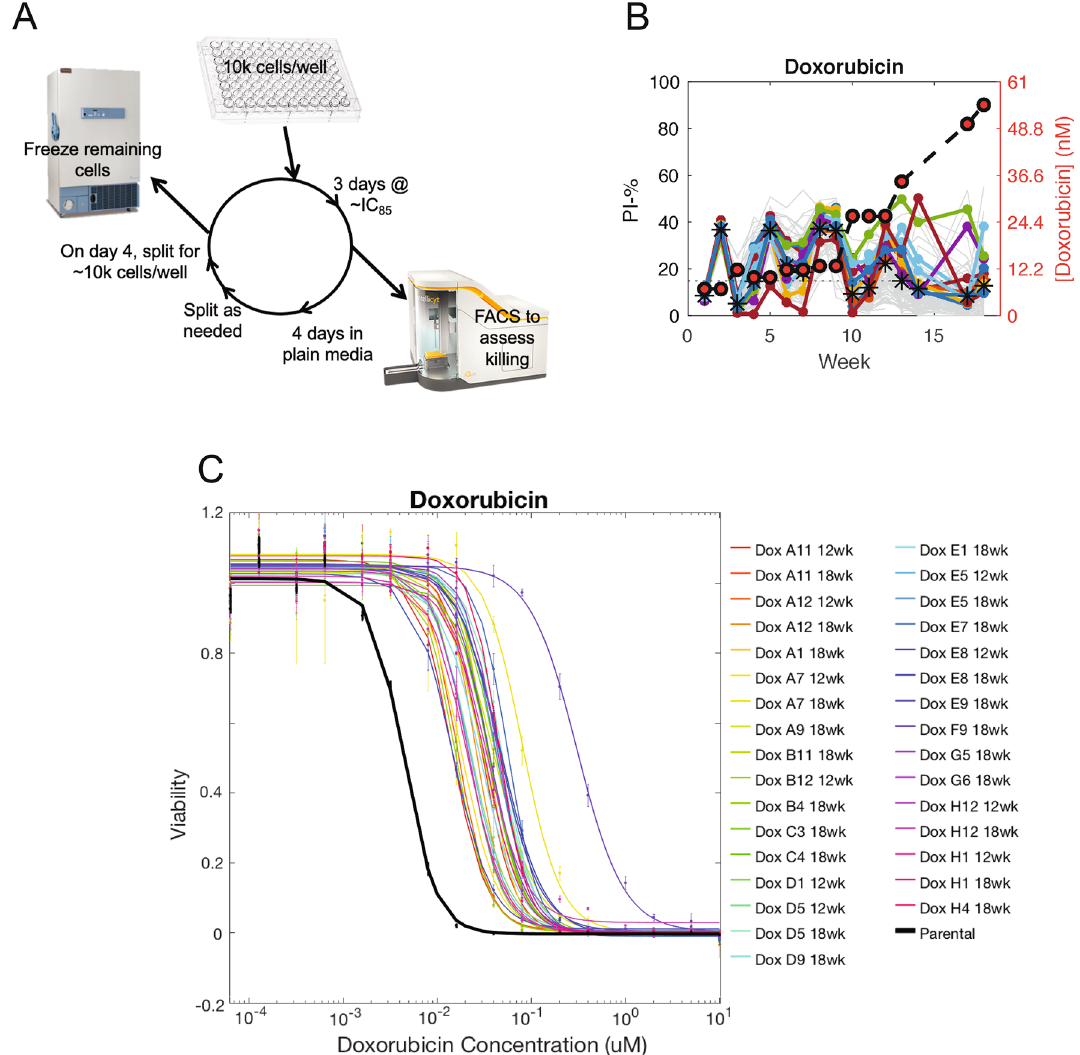
Figure 1. Protocol to create multiple evolutionary replicates of classical chemotherapy-resistant cell lines in parallel. (A) Schematic of protocol. In each cycle, 10,000 cells were seeded in each well of a 96-well plate and treated at a dose to kill 85% of cells after three days. Killing was assessed via FACS and cells were allowed to recover for four days. Cells were split, frozen, and the cycle re-started. (B) The fraction of live cells present in each well over each cycle of the resistance evolution experiment as assessed by PI staining (left y-axis). The dose of doxorubicin used each week is plotted with red circles on the right y-axis. Colored lines represent the most viable cell lines over the last five cycles of the experiment of the experiment. (C) Quantification of sensitivity to the selection drug after 12 or 18 cycles of